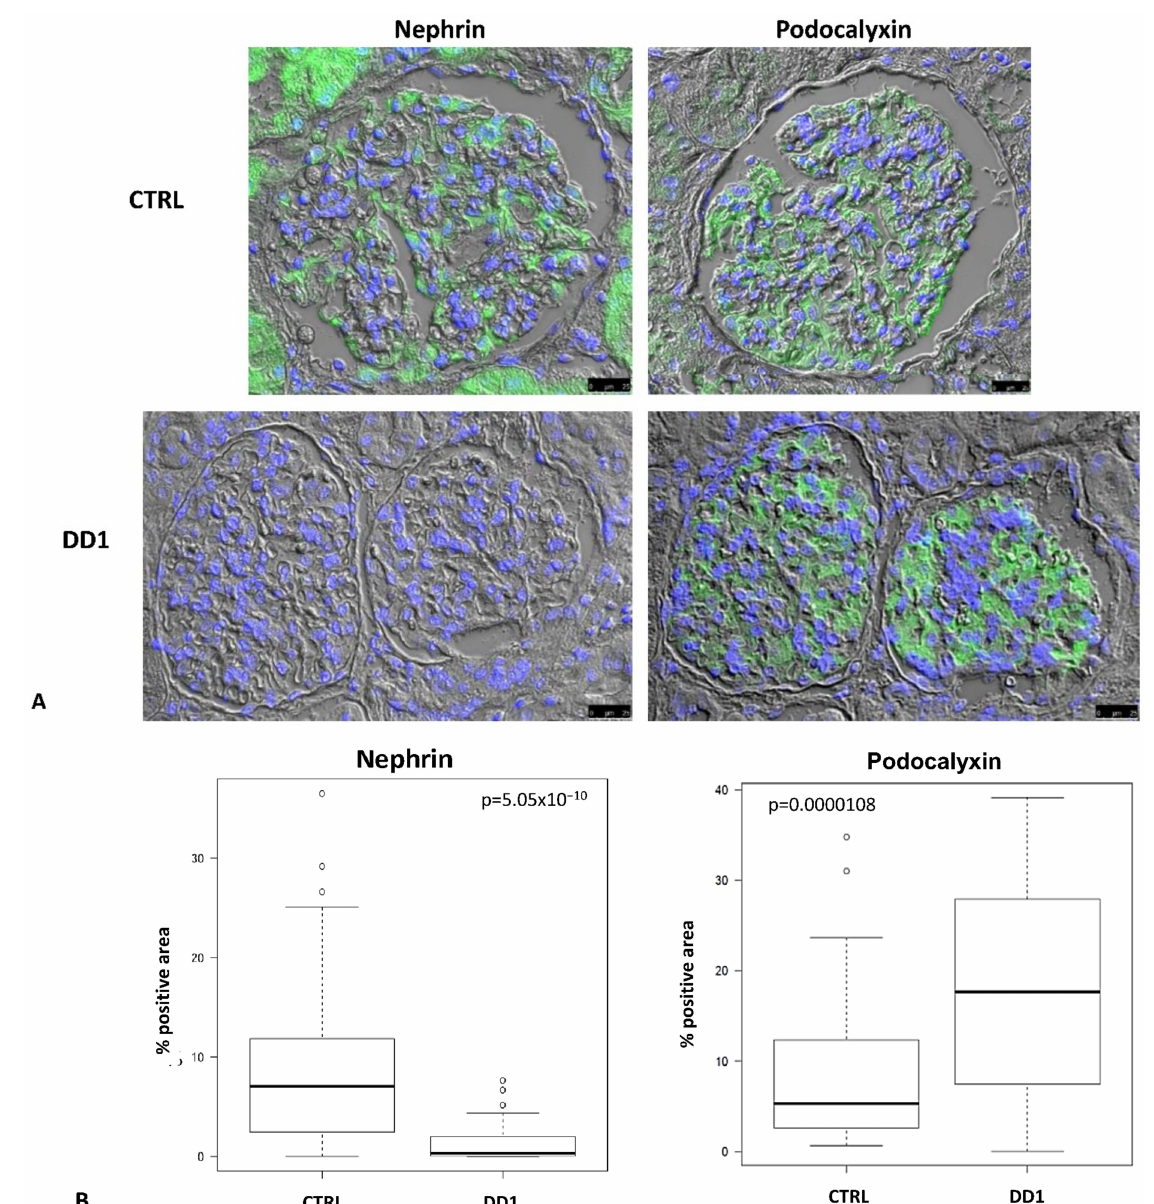
Figure 1. Immunofluorescence (IF) in serial sections of glomeruli showing the expression pattern of nephrin and podocalyxin in control (CTRL) and Dent Disease 1 (DD1) kidneys biopsies. ( A ): Repre- sentative image disclosing the absence of nephrin positivity in DD1 glomeruli while podocalyxin immunolabeling was present in both CTRL and DD1 glomeruli. Green: Nephrin; Blue: DAPI. Images were acquired using a DMI6000CS-TCS SP8 fluorescence microscope (Leica Microystems, Wetzlar, Germany) with 20 × /0.4 objective. Scale bar 25 µ m. ( B ): Morphometric evaluation of nephrin and podocalixin IF in CTRL and DD1 glomeruli. Boxplots show IF staining scores (% positive